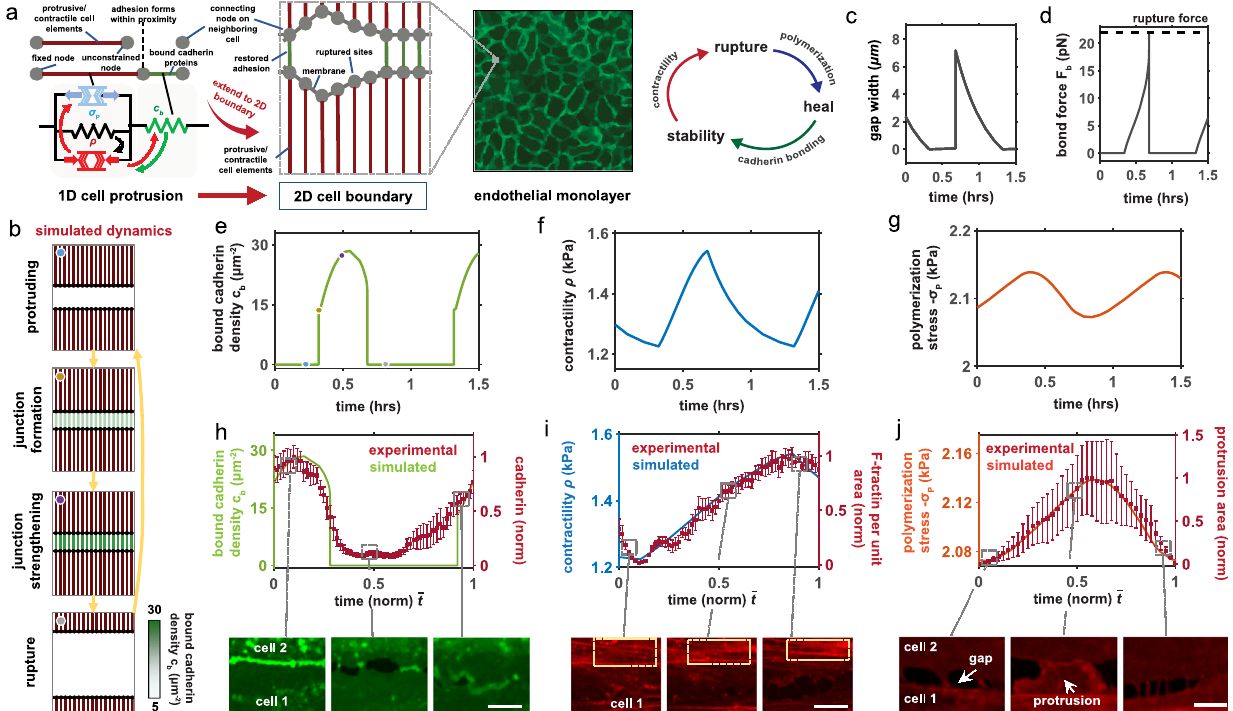
Fig. 3 | Dynamic junction rupture and recovery. a The 2D model discretely considers independent protrusions comprised of cytoskeletal (protruding/ con- tractile) elements (red), adhesion elements that can rupture and reform (green), and membrane/cortical actin elements that connect the protrusions (grey); ( b ) Simulated cell-cell boundary showing cycle of protrusion, junction formation, cadherin binding, and rupture at high tension; Predicted ( c ) gap size, ( d ) cadherin bond force, ( e ) bound cadherin density, ( f ) cell contractility, and ( g )